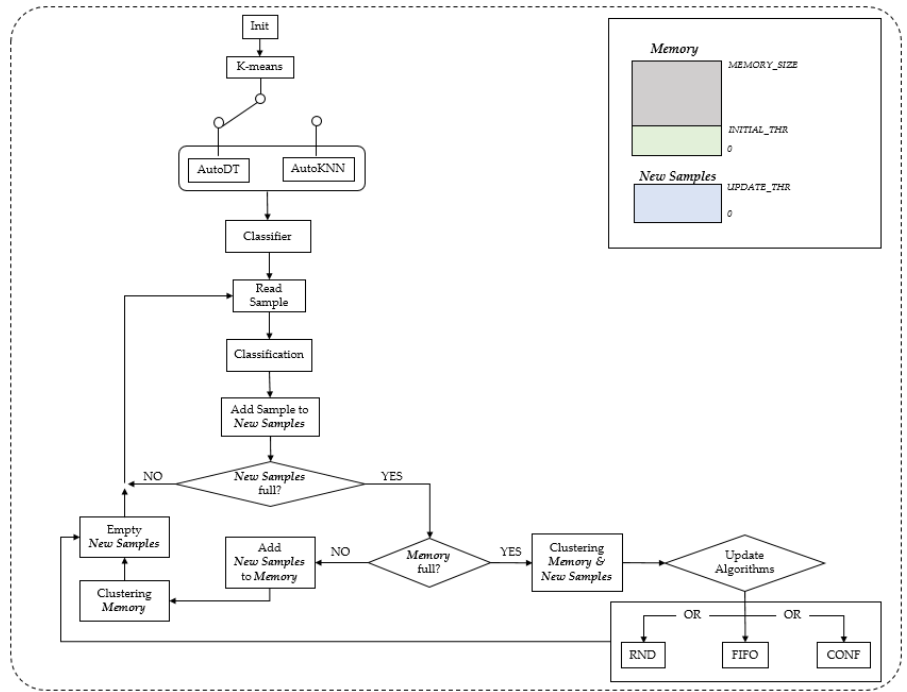
Figure 2. The AEP workflow.